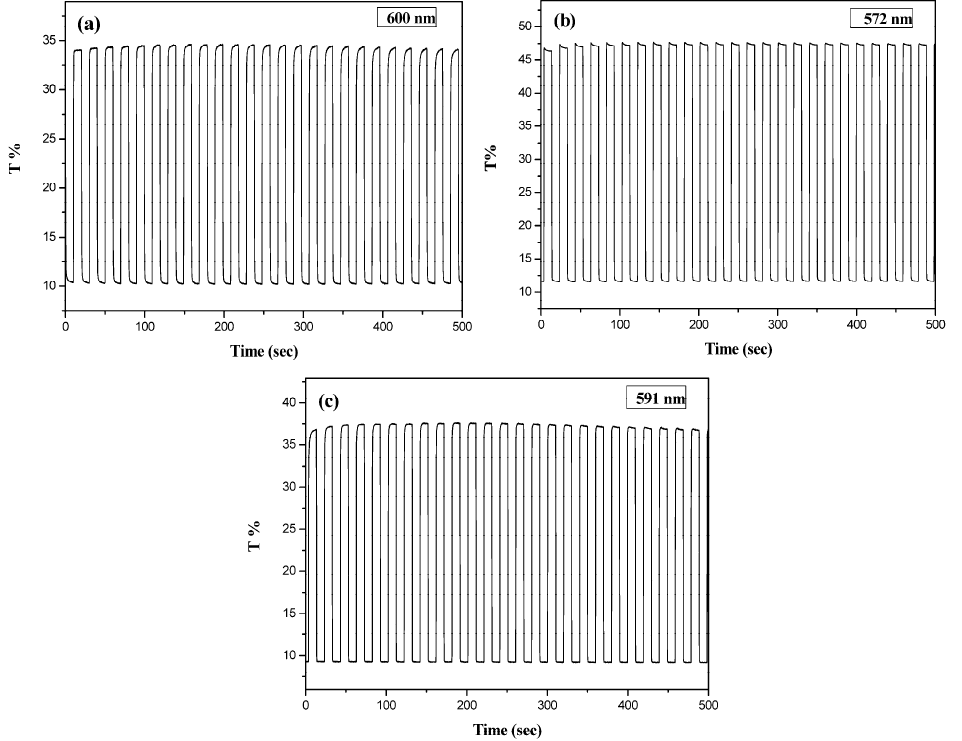
Figure 8. Optical contrast of ( a ) PtCz/PEDOT ( b ) PtCz/PProDOT-Me 2 , and ( c ) PtCz/PProDOT-Et 2 ECDs in an ACN/DCM (1:3, by volume) solution containing 0.2 M LiClO 4 between 0.0 V and 1.8 V with a residence time of 10 s.